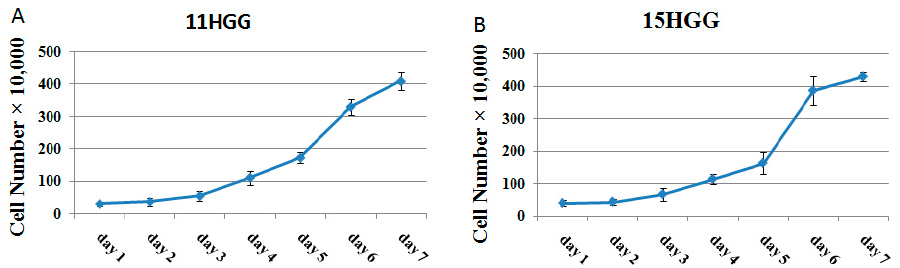
Figure 1. Growth curve of high grade glioma (HGG) cells. Cells were seeded into 12-well plates at a concentration of 2–5 × 10 4 cells/well and incubated at 37 °C in standard medium. The number of the cells was determined every day by hemocytometric counting, using trypan blue. Each experiment was repeated three times. Doubling time was calculated using the slope of the logarithmic phase of growth curve.